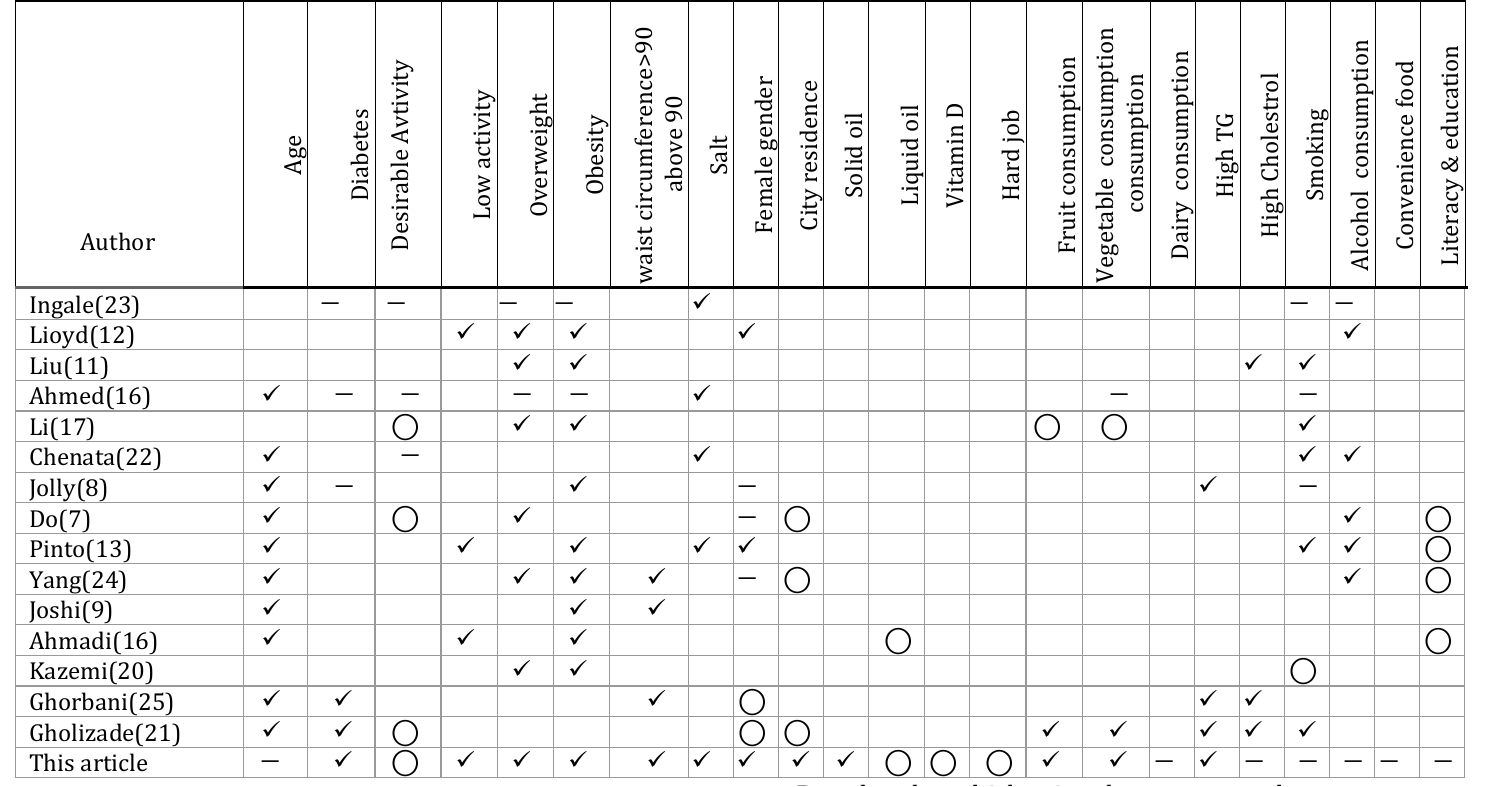
Table 3. Role of factors affecting hypertension in different studies